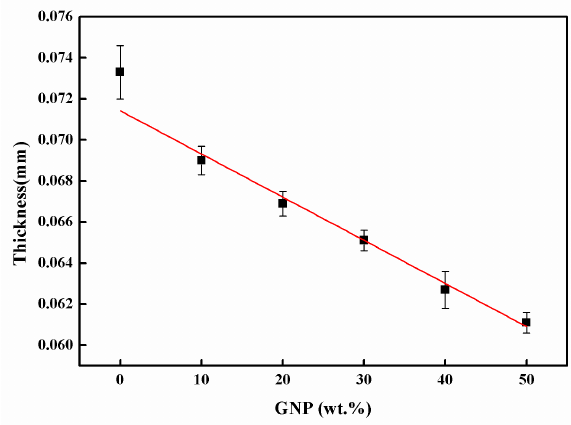
Figure 6. Thickness of hybrid film varied with the GNP weight percentages.